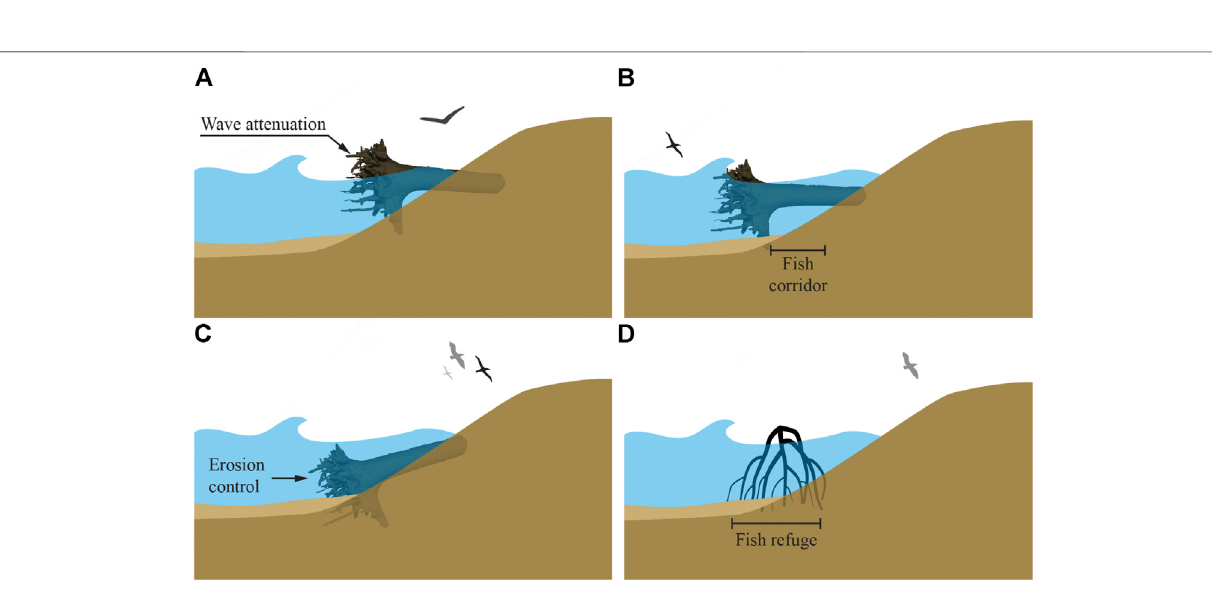
Frontiers in Robotics and AI |